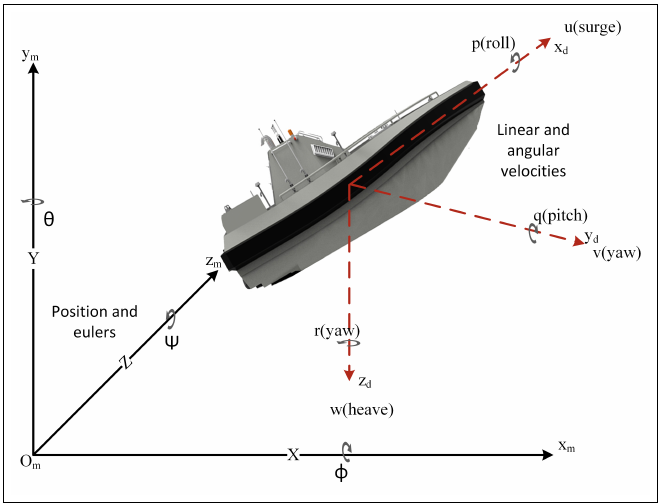
Figure 5. USV motion in six